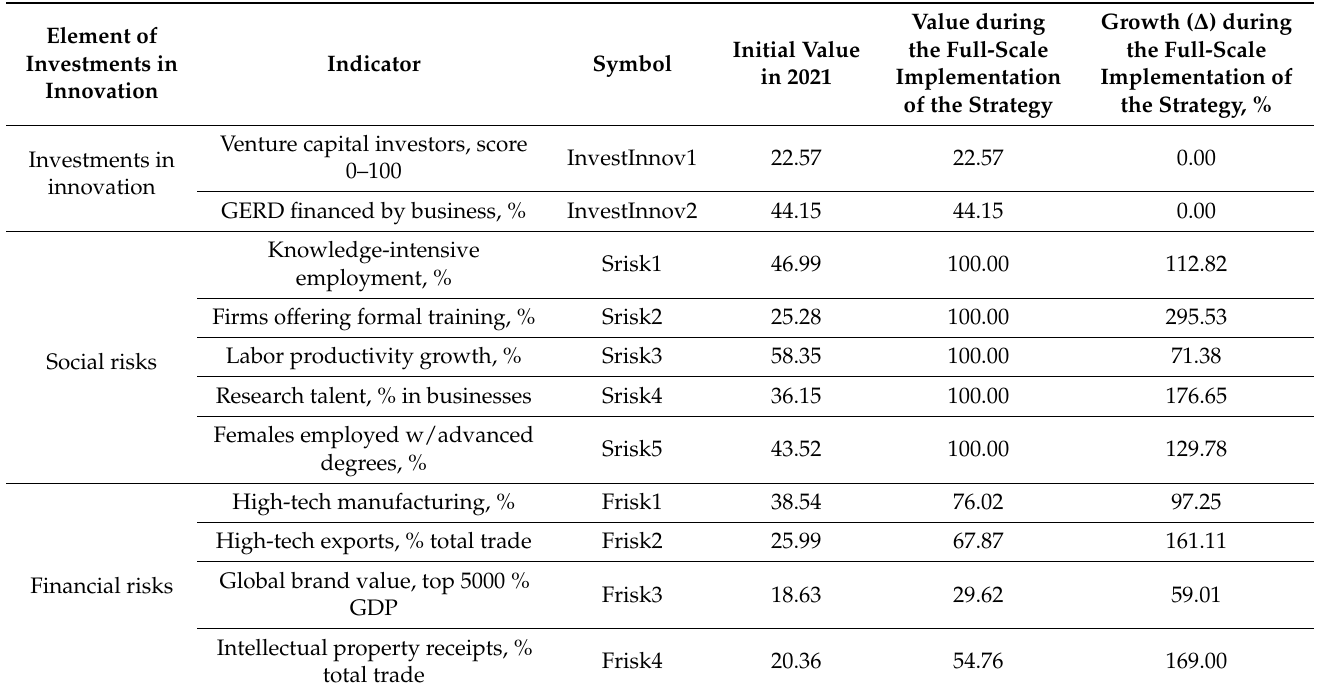
Table 10. Consequences of the full-scale implementation of a new (socially-oriented) strategy of managing the risks of investments in innovation that is based on corporate social